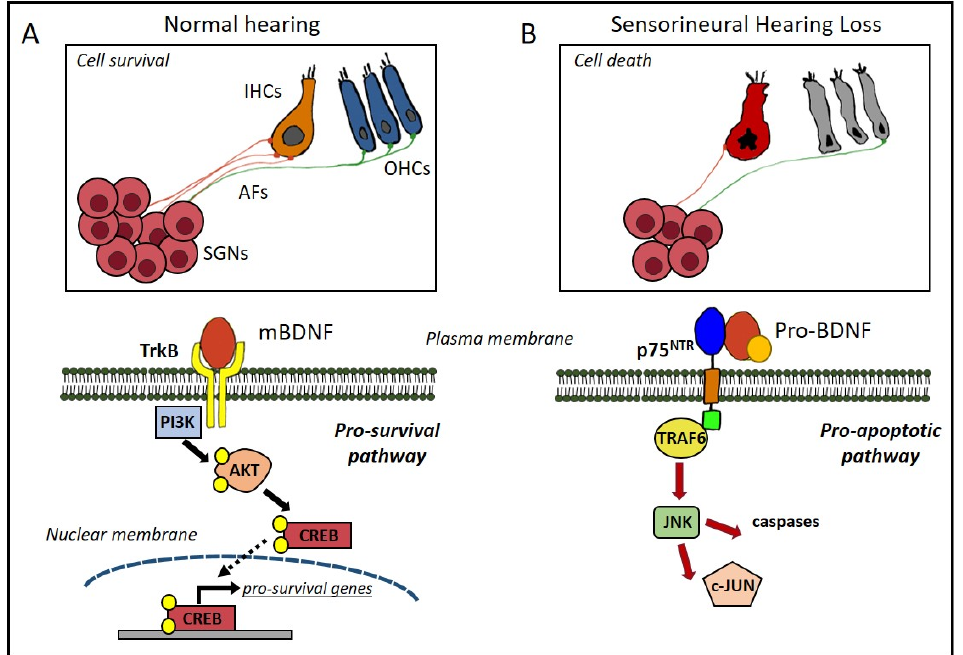
Figure 2. Schematic representation of TrkB and p75 NTR pathways in normal hearing and in sensorineural hearing loss. In normal hearing cochlea ( A ), mBDNF binds TrkB receptor on the plasma membrane of spiral ganglion neurons (SGNs) and activates PI3K/AKT pathway. PI3K phosphorylates and activates AKT (phosphorylation sites indicated by yellow spots), which in turn phosphorylates the transcription factor CREB, which translocates into the nucleus and induces pro ‐ survival gene expression. In damaged cochlea ( B ), pro ‐ BDNF binds the p75 NTR receptor on the SGN plasma membrane and activates signalling proteins such as TRAF6 and JNK, which are involved in the activation of c ‐ JUN and caspases, leading to cell death. IHCs, inner hair cells; OHCs, outer hair cells; Afs, afferent fibres; SGNs, spiral ganglion neurons; TrkB, tropomyosin receptor kinase B; PI3K, phosphatidylinositide 3 kinase; AKT, protein kinase B; CREB, cAMP response element ‐ binding protein; p75 NTR , p75 neurotrophin receptor; TRAF6, TNF receptor ‐ associated factor 6; JNK, c ‐ Jun N ‐ terminal kinases; c ‐ JUN, transcription factor Jun.